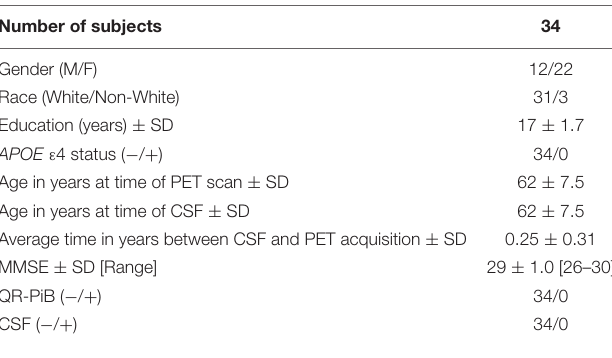
TABLE 1 | Cohort characteristics of the statistical parametric mapping (SPM)